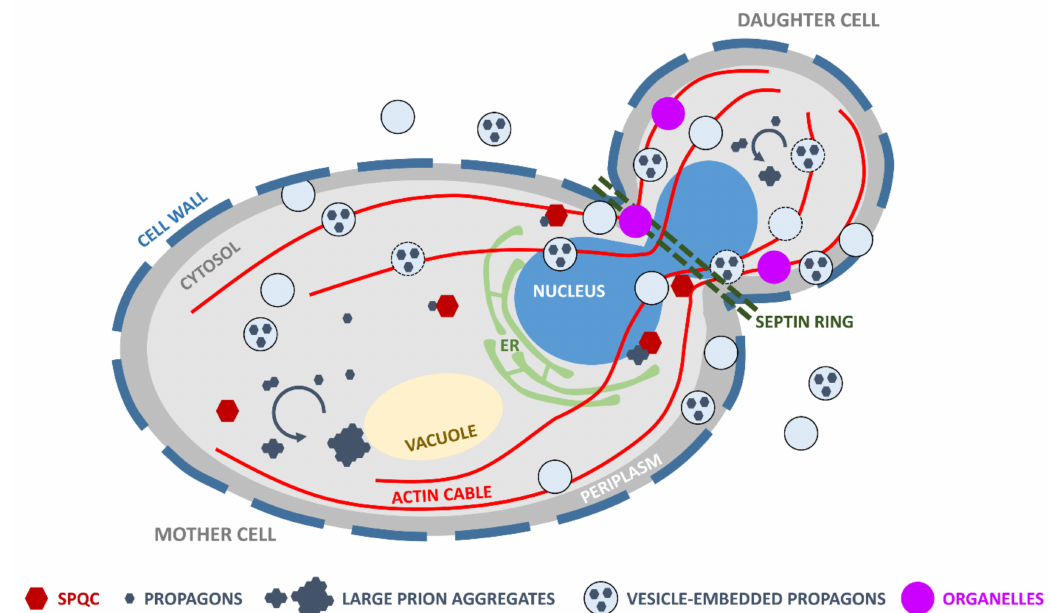
Figure 2. Hypothetical model of vesicle-mediated transmission of prion particles in the context of bud formation and spatial quality control. Yeast prions self-replicate by the conversion of newly synthesized soluble monomers to a prion conformation and their subsequent incorporation within high-molecular-weight prion assemblies (solid blue arrow). Unidentified prion species or “propagons” (hexagons) are cytoplasmically transmitted to the daughter cell where they initiate a new round of prion self-replication (solid blue arrow). Cytosolic prion particles are engaged by components of the spatial protein quality control (SPQC; red hexagons), such as molecular chaperones and proteolytic machineries, which ensure that most aggregates are not transmitted to the daughter cells. In addition, crowding at the mother–daughter cells junction, due to the presence of the septin ring (green dashed lines), nucleus, actin cables, vesicles and organelles (e.g., mitochondria, endoplasmic reticulum (ER); purple circles) may prevent effective transmission of “naked” propagons. Yeast prions are packaged within vesicles that are exported across the cell wall (depicted as a thick dashed line to highlight its dynamic nature) and to the extracellular medium. Vertical transmission of yeast prions could be mediated by propagons packaged within intracellular vesicles. These vesicles may be transported on actin cables to the bud where their content would be released in the cytosol to initiate a new cycle of prion self-replication. Periplasmic vesicles could also mediate the transport of propagons by diffusion in the periplasm and reinternalization in the bud (ER: endoplasmic reticulum; SPQC: spatial protein quality control). In both cases, vesicle-encapsulated propagons may escape SPQC, resulting in efficient and faithful prion transmission